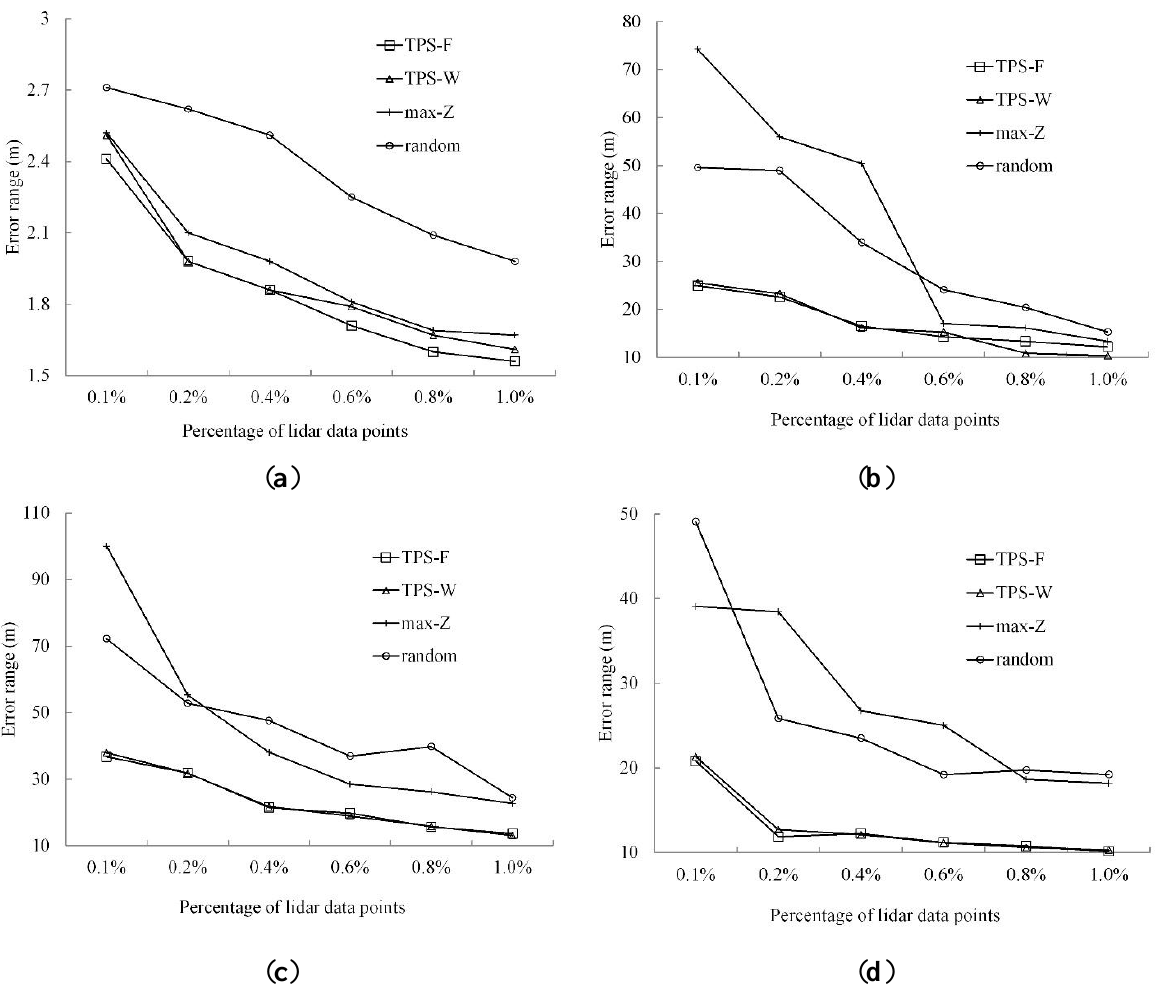
Figure 11. Comparison of percentage of LiDAR data points ( i.e. , ratio of the number of selected critical points to the whole number of LiDAR points) versus error range between the four methods in the sites with ( a ) flat, ( b ) undulating, ( c ) hilly and ( d ) mountainous terrains. Comparison of percentage of LiDAR data points versus RMSE between the four methods in all the study sites are provided in Figure 12. The RMSEs of almost all methods become smaller when the number of critical points increases. This result can be expected as the larger number of data points always leads to the more correct surface description [45]. Compared with max-Z, the random method performs well due to its even distribution of data points (Figures 2c–5c). The two versions of TPS are more accurate than the other methods at almost all study sites, especially for the hilly terrain. It should be noted that irrespective of terrain morphology, TPS-W always performs better than TPS-F. This is due to the fact that ANUDEM achieves the hydrologically corrected DEMs at the cost of biasedly changing a certain number of elevations